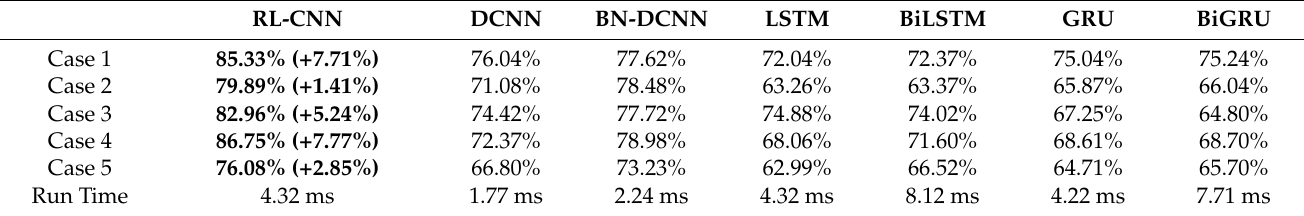
Table 5. The prediction accuracy of different radial